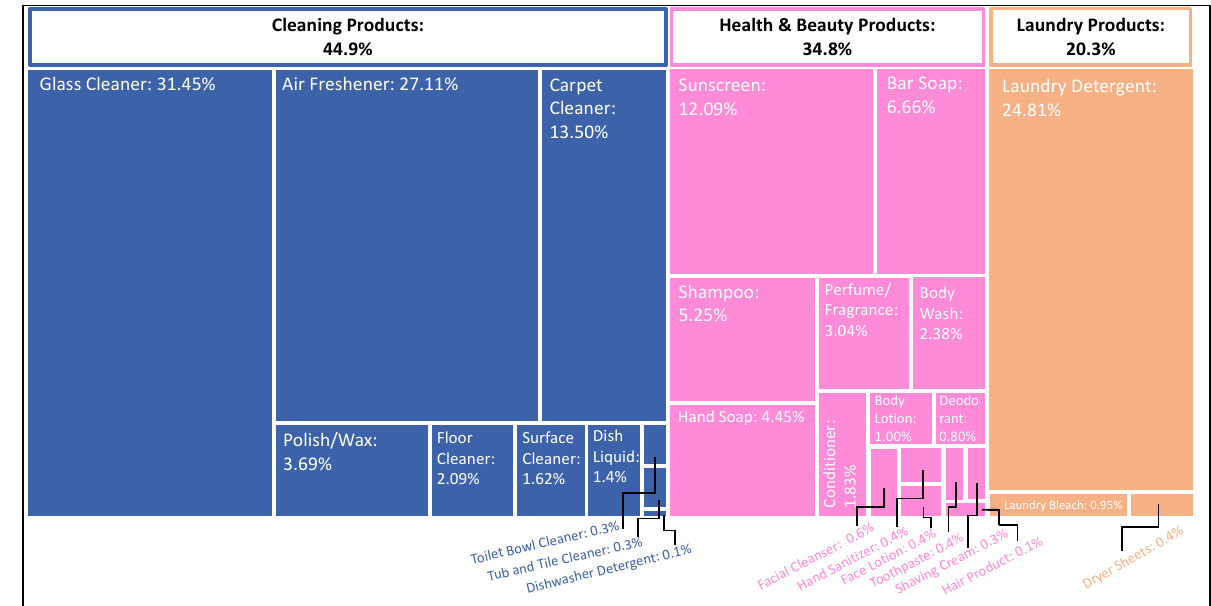
Table 4. Summary by household size of endocrine-disrupting compound (EDC) footprint calculator results from 39 citizen scientists. Summary results include the average footprint per household size, standard deviation, coefficient of variation, and footprint ranges.